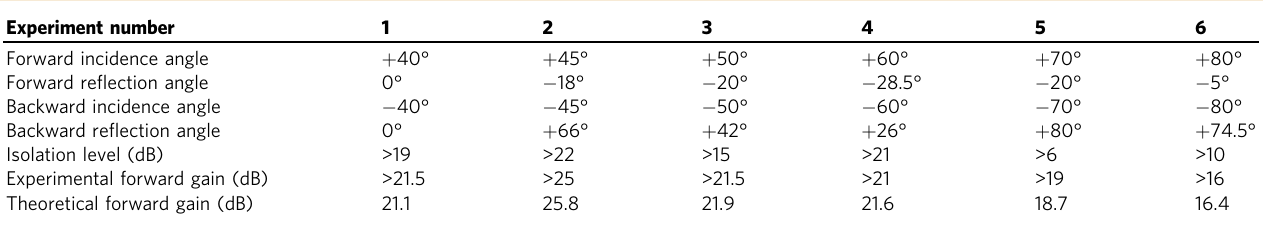
Table 1 Full-duplex nonreciprocal re fl ective beamsteering at 5.81